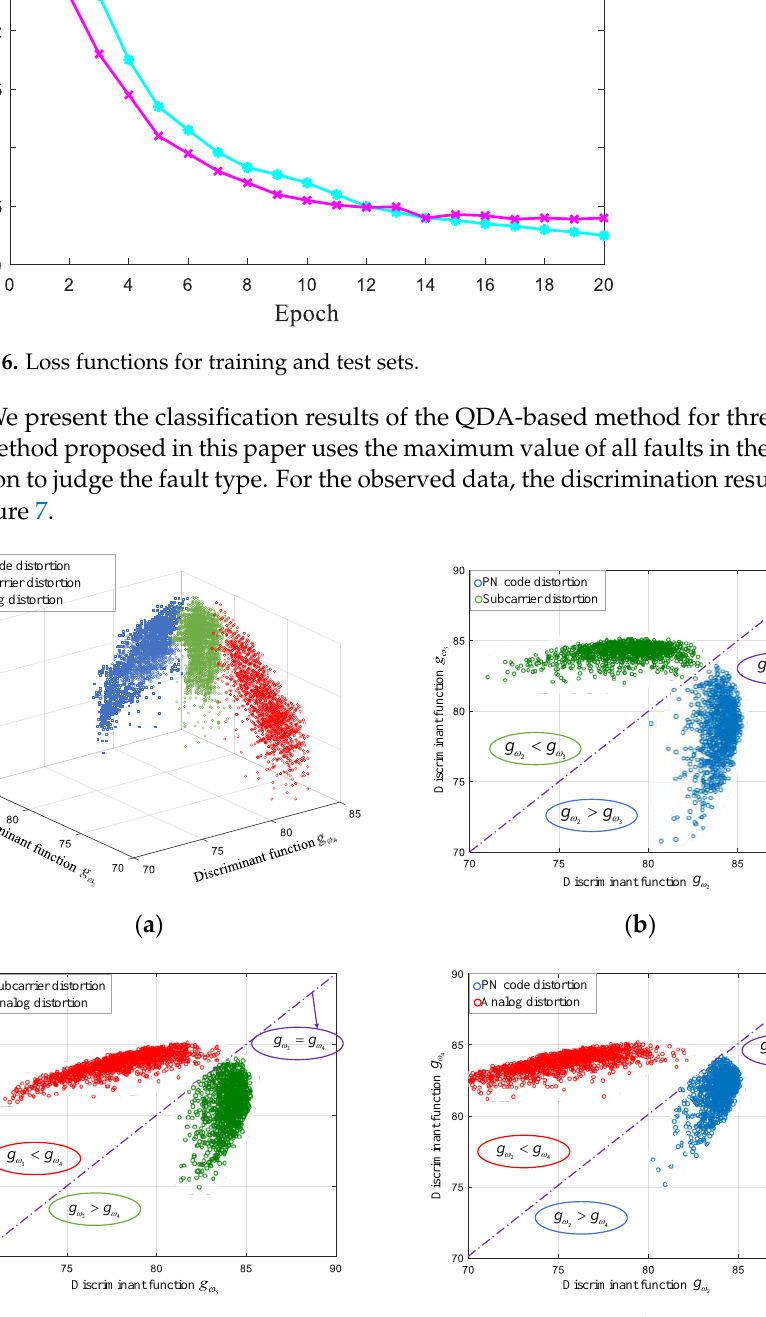
, 𝑔 𝜔 , , g ω , 2 3 2 3 , 𝑔 𝜔 , and 2 3 3 3 3